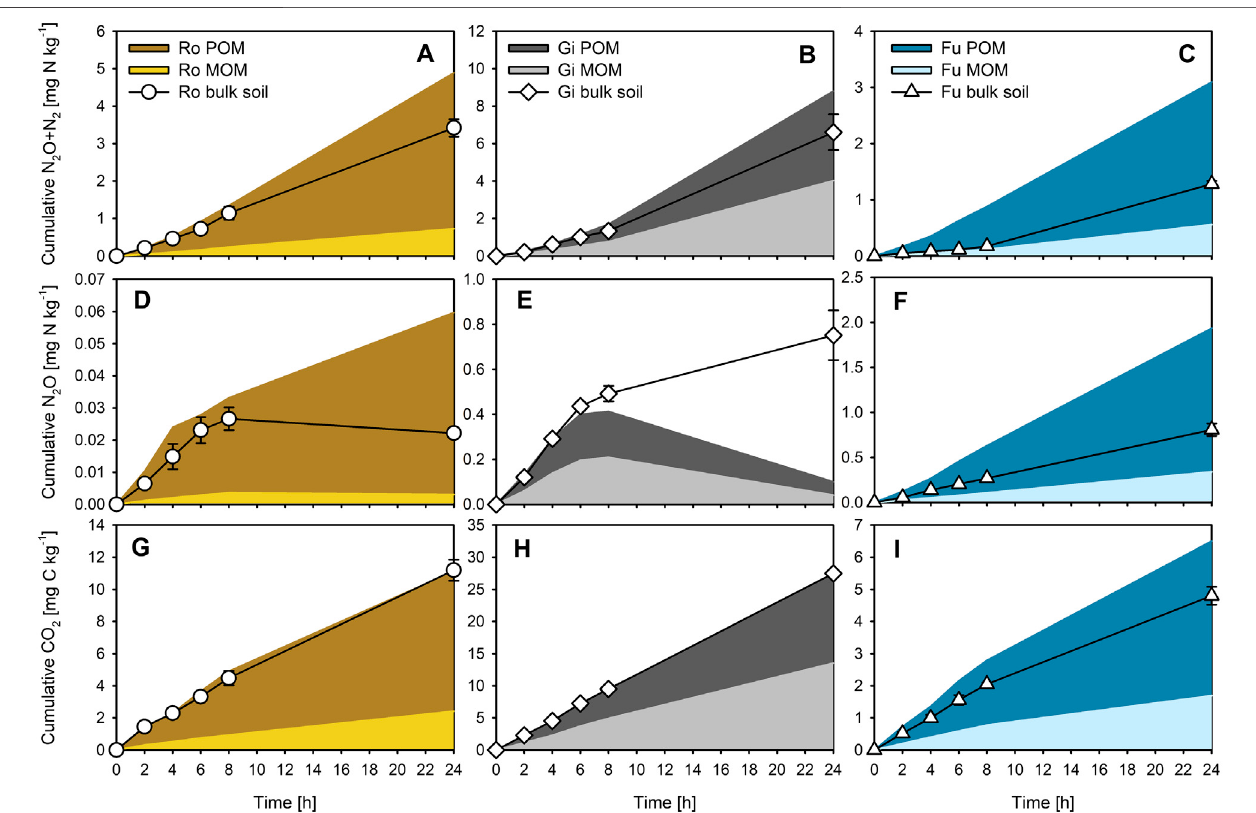
FIGURE 3 | Estimated cumulative (A – C) N 2 O + N 2 , (D – F) N 2 O, and (G – I) CO 2 production induced by WEOC derived from particulate and mineral-associated organic matter (POM, MOM), and measured cumulative production of the respective gases for the bulk soils, during anoxic incubation at 20 ° C of the soils from Rotthalmünster – Ro, Giessen – Gi, and Fuhrberg – Fu. Error bars represent SD of means (n (cid:2)